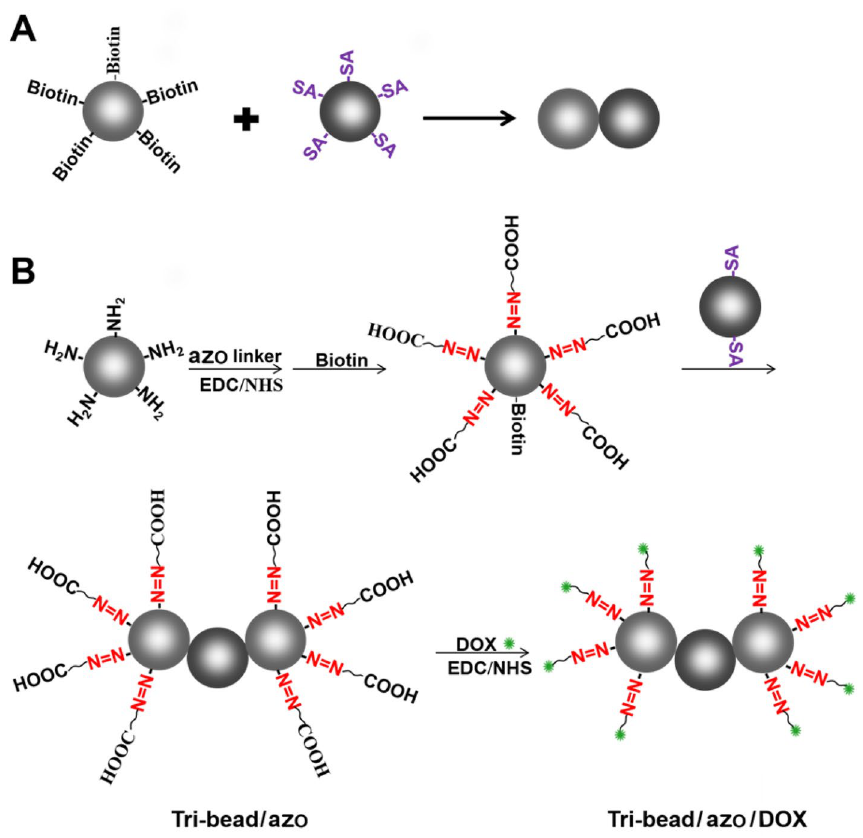
Figure 1. ( A ) The synthesis of bi-bead structures formed by conjugating biotin-coated magnetic beads with streptavidin (SA) coated magnetic beads. ( B ) Tri-bead microrobot linked by azo, and the chemical structure of azo and